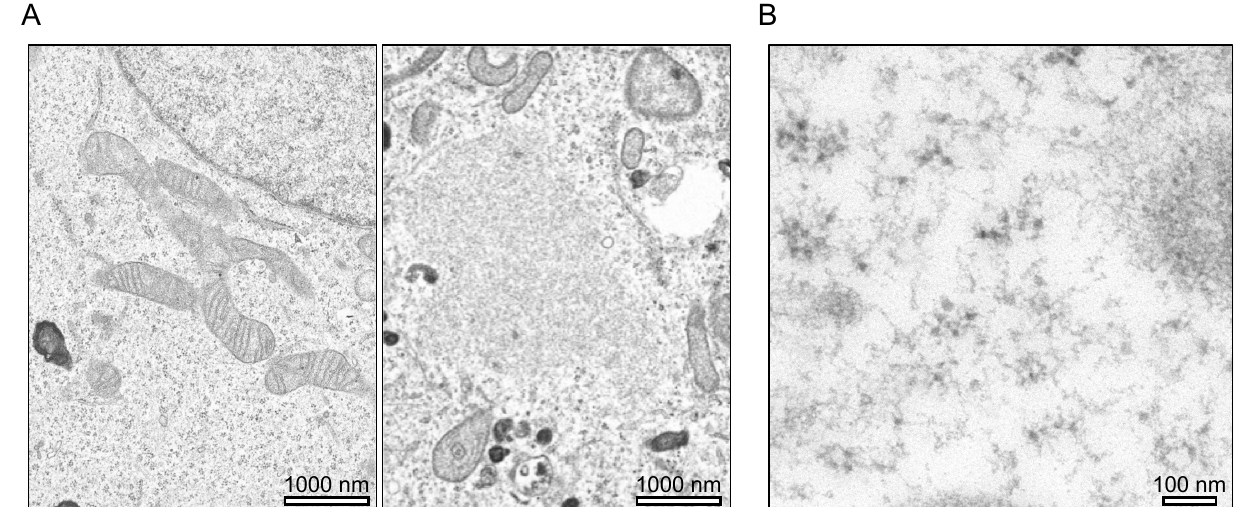
Figure 2. Electron micrographs of HeLa cells transfected with TFAM siRNA (day 4). ( A ) The image on the right shows HeLa cells with TFAM siRNA, and the image on the left shows HeLa cells without TFAM siRNA. TFAM siRNA-transfected HeLa cells show aggregates with no membrane structure and disrupted mitochondria. ( B ) Detection of dsDNA by anti-dsDNA antibody (35I9 DNA) and 15-nm gold particles. Signals of dsDNA are shown as dark spots.